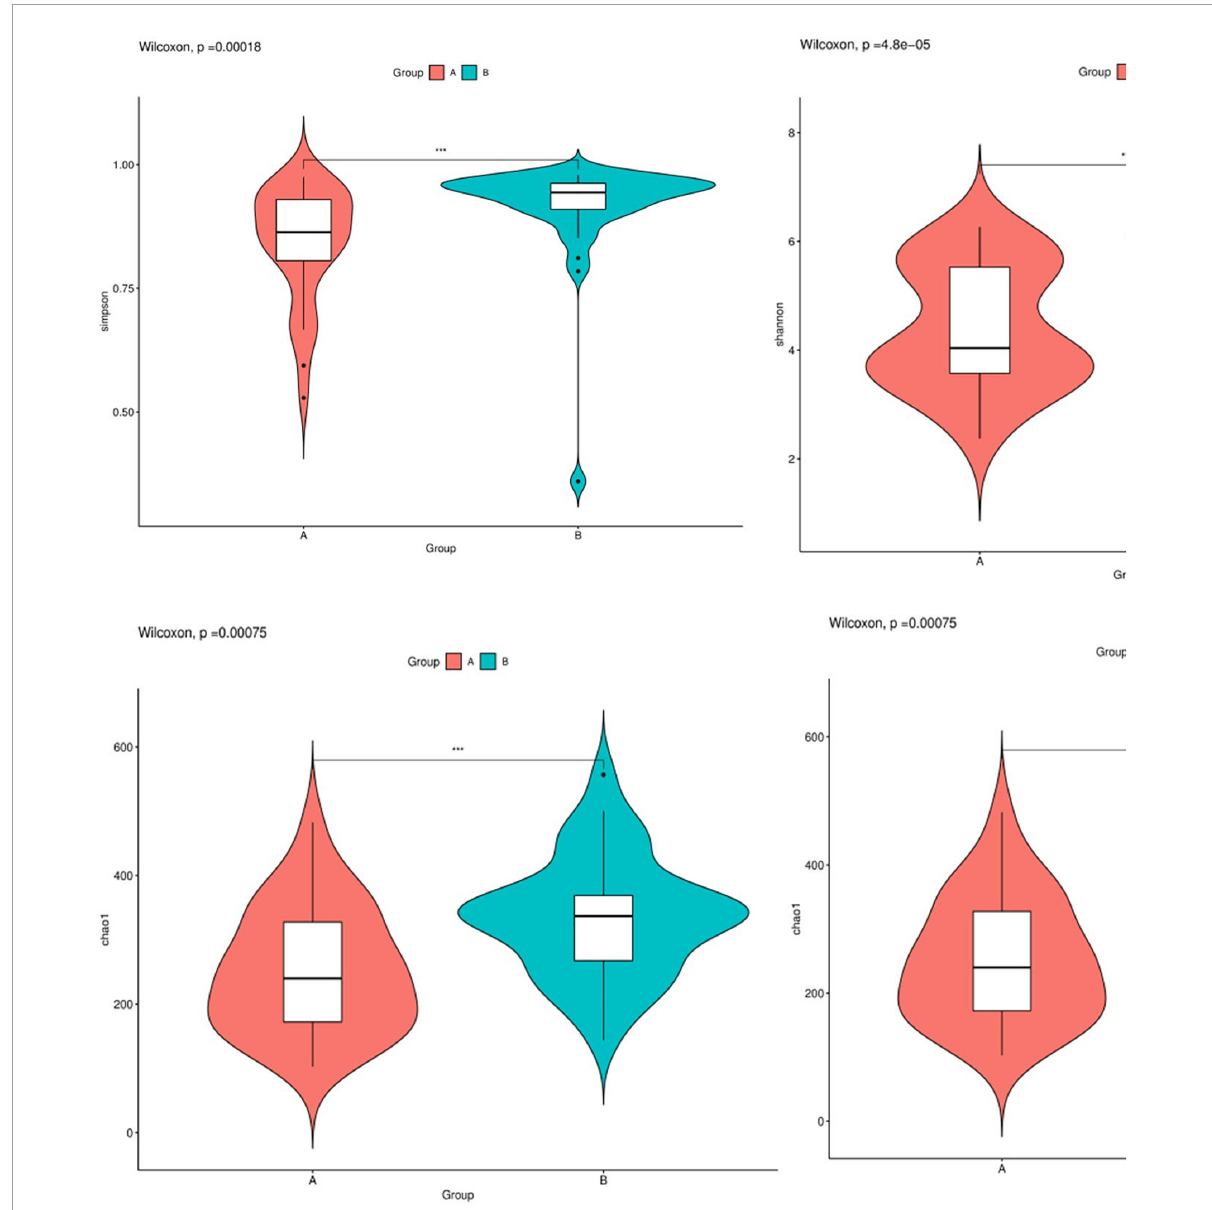
FIGURE8 Difference analysis of alpha diversity index between